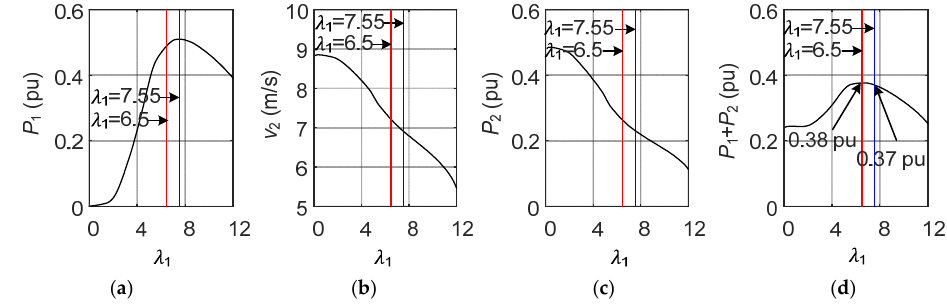
Figure 6. Comparison between WT 1 operating at the tip speed ratio of 7.55 and 6.5, at the wind direction of 270° and ambient wind speed of 9 m/s: ( a ) the active power of WT 1 , where the base value is 5 MW; ( b ) the wind speed of WT 2 ; ( c ) the active power of WT 2 , where the base value is 5 MW; ( d ) the total active power of the wind farm, where the base value is 10 MW.